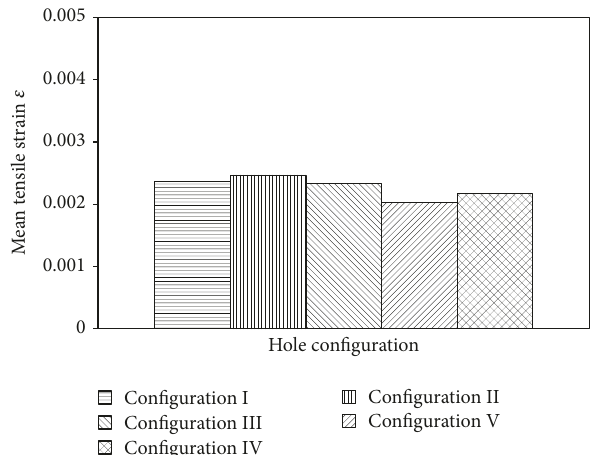
Figure 8: Tensile strain of lontar fiber-reinforced composites with different hole configuration.